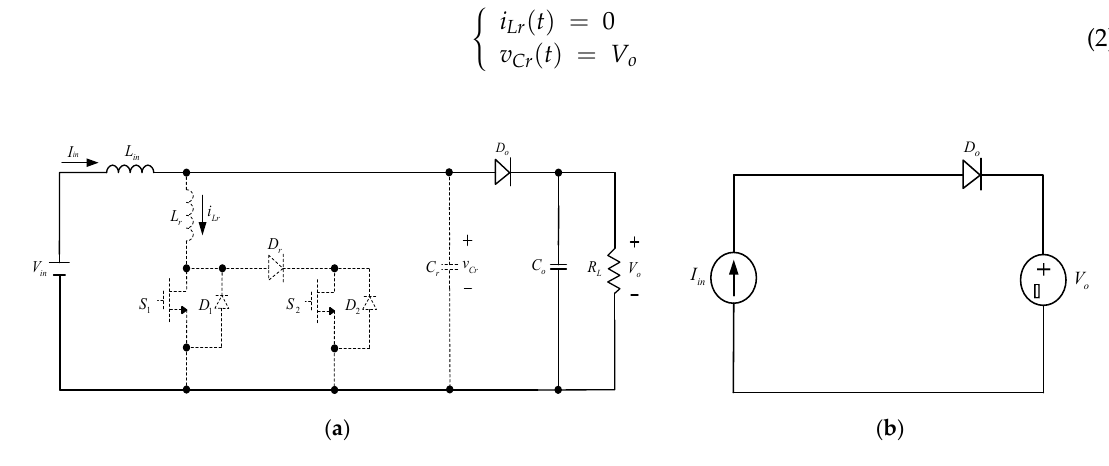
Figure 3. ( a ) Current flow in state 0; ( b ) Equivalent circuit of ( a ).